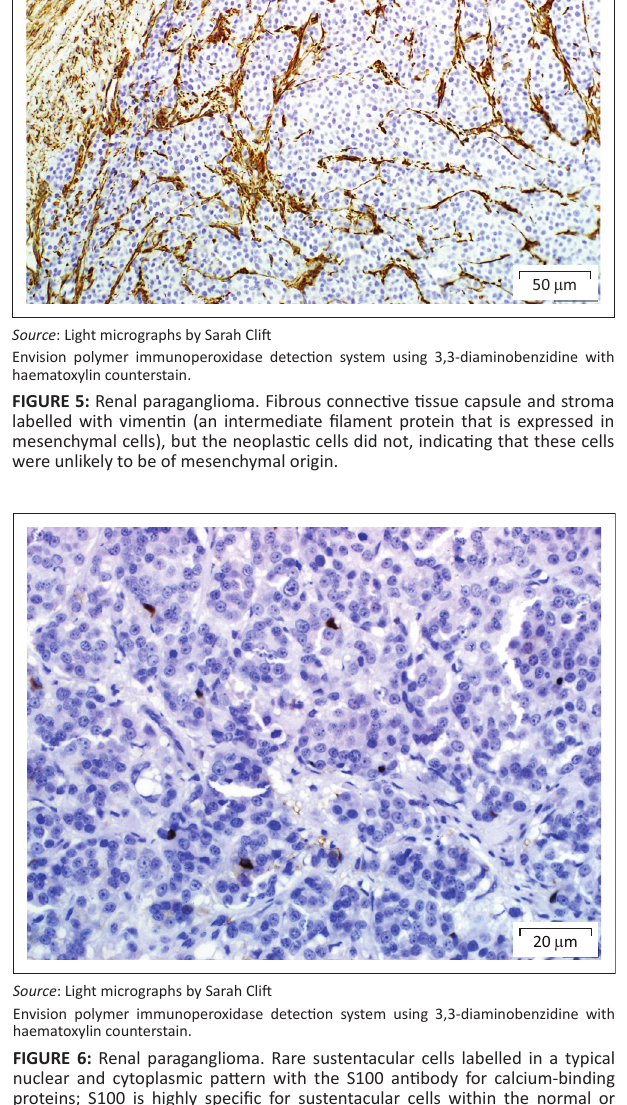
FIGURE 4: Renal paraganglioma. Neoplastic cells exhibiting strong diffuse chromogranin A-specific cytoplasmic positivity, associated with dense-core secretory vesicles/granules in neuroendocrine cells.